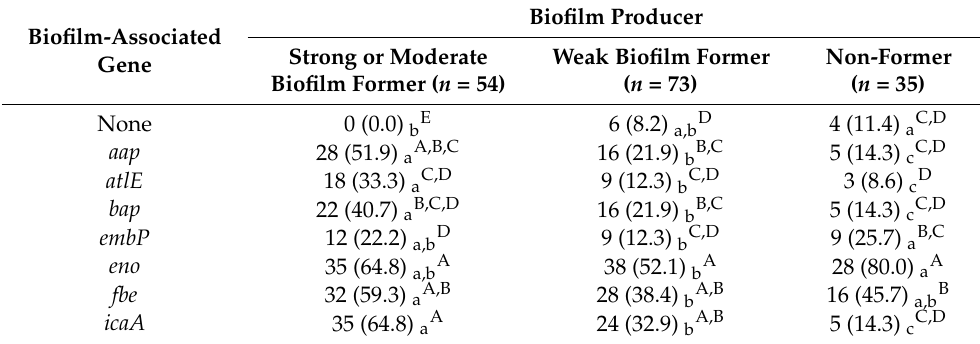
Table 3. Relationship between multidrug resistance (MDR) and biofilm-forming ability in 162 coagulase negative staphylococci from